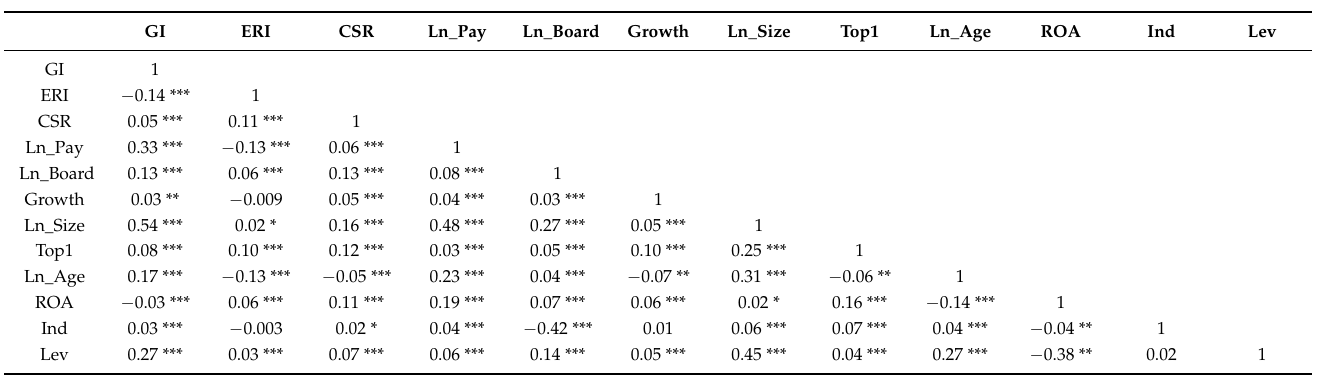
Table 3. Correlation